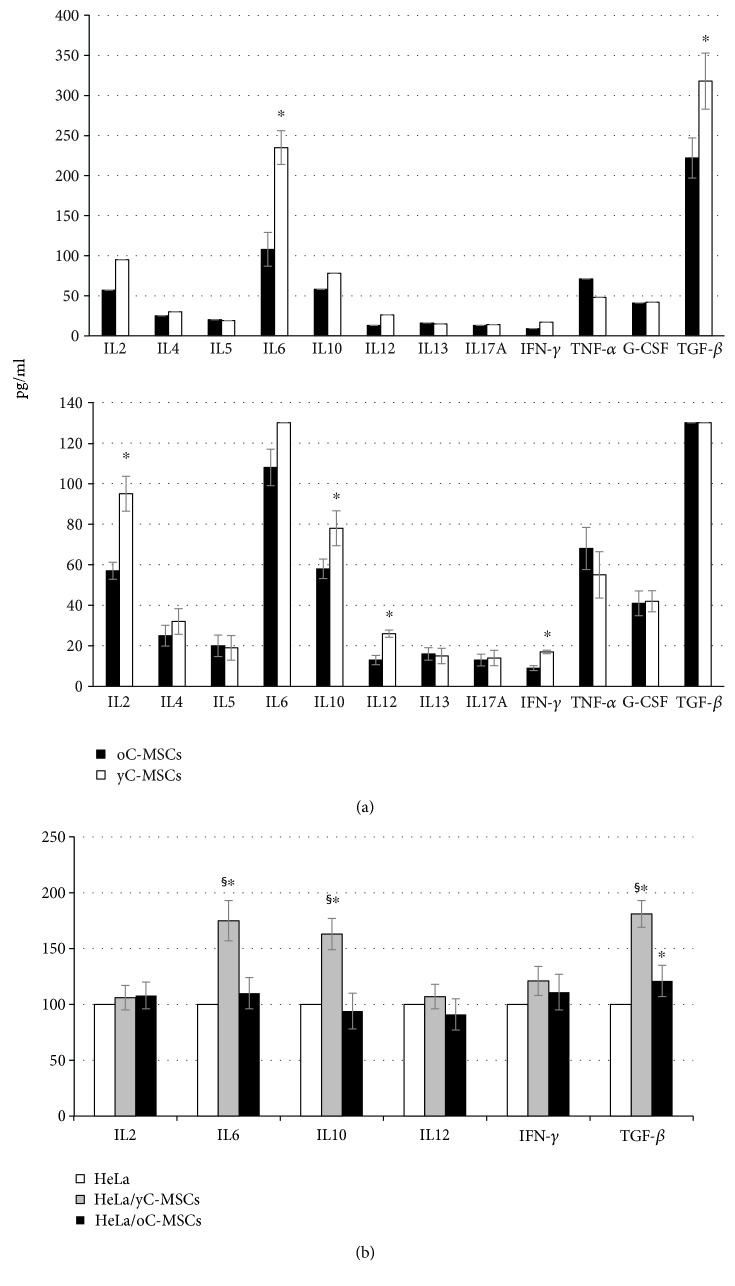
Detection of secreted cytokines in yC-MSCs and oC-MSCs by ELISA before (a) and after cocultures with HeLa cells (b). (a) Level of secretion of selected cytokines referred to inflammation detected in MSCs from young (yC-MSCs) and old (oC-MSCs) cervixes. Data, expressed in pg/ml, are means ± SD from analyses performed on three separate experiments. (b) Histograms displaying the levels of the same cytokines detected after indirect cocultures with HeLa cells for 72 hours. The level of each cytokine is shown as % (mean ± SD from three independent experiments) of the level detected in control HeLa cells. ∗p < 0.05 for HeLa/yC-MSCs or HeLa/oC-MSCs versus HeLa and §p < 0.05 for HeLa/yC-MSCs versus HeLa/oC-MSCs.